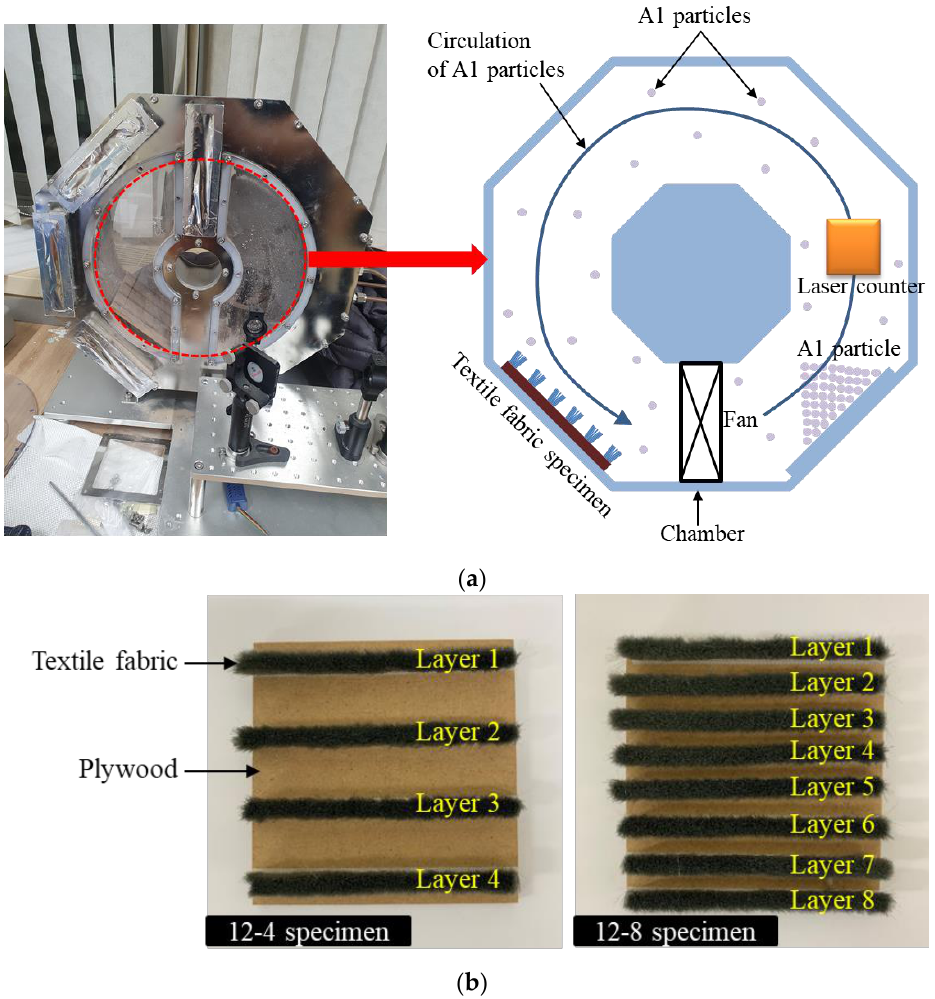
Figure 4. Test setup for measuring fine dust particle removal rates. ( a ) Schematic of machine for counting the fine dust particles. ( b ) Details of textile fabric specimens.